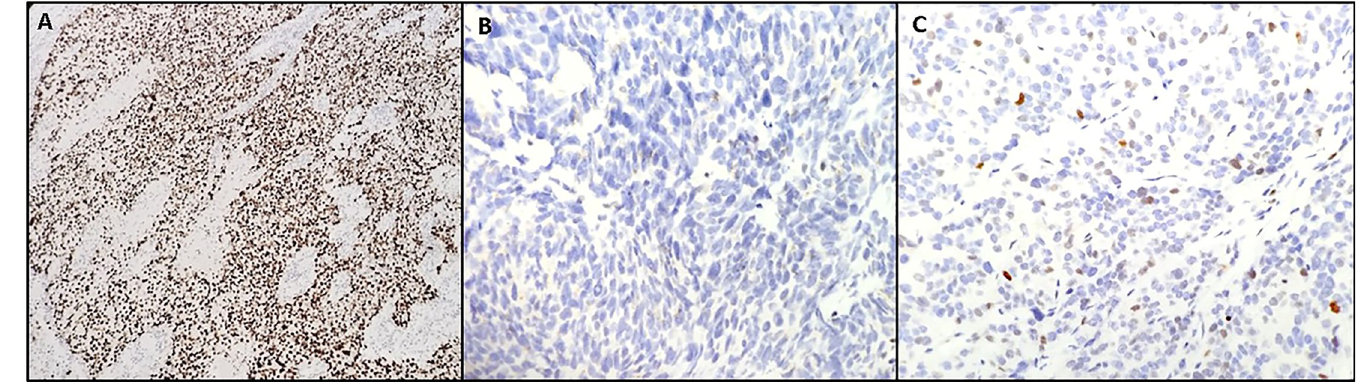
Fig 3. p53 immunohistochemical expression pattern in prostate carcinomas with TP53 alterations. A- Diffuse nuclear positivity ( > 90%) is seen in a case with TP53 p.R273C mutation (10x). B- TP53 structural rearrangement resulting in complete loss of TP53 expression. Staining of background stromal cells and inflammatory cells seen as an internal control (20x). C- Prostate carcinoma with wild type TP53 showing weak and patchy (less than 5%) nuclear staining (20x).